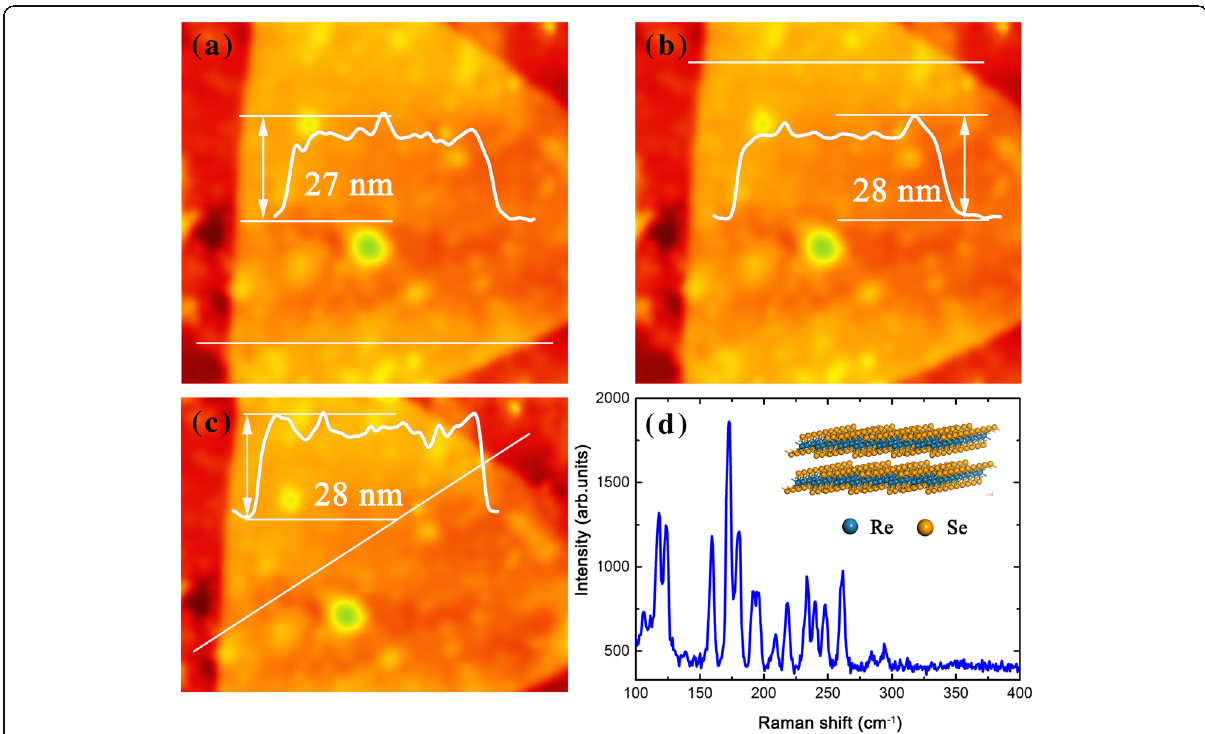
Fig. 3 a , b , and c AFM image and thickness of ReSe2, and d Raman spectrum and crystal structure of ReSe2